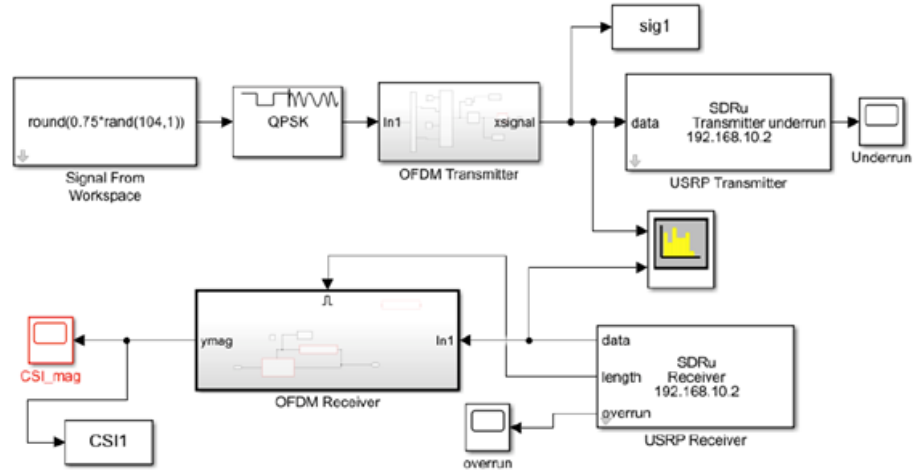
Figure 4. Simplified orthogonal frequency division multiplexing Simulink model for experiments